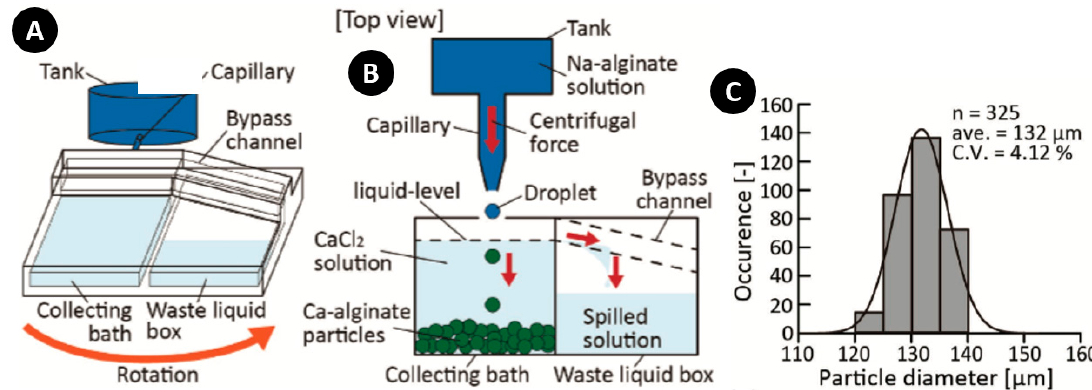
Figure 12. ( A , B ) Conceptual illustration of oil-free production of monodisperse Ca-alginate particles with a by-pass channel and waste chamber for transferring spilled solution in order to keep the CaCl 2 solution level constant; ( C ) Diameter distribution of Ca-alginate particles. Reprinted with permission from [121].